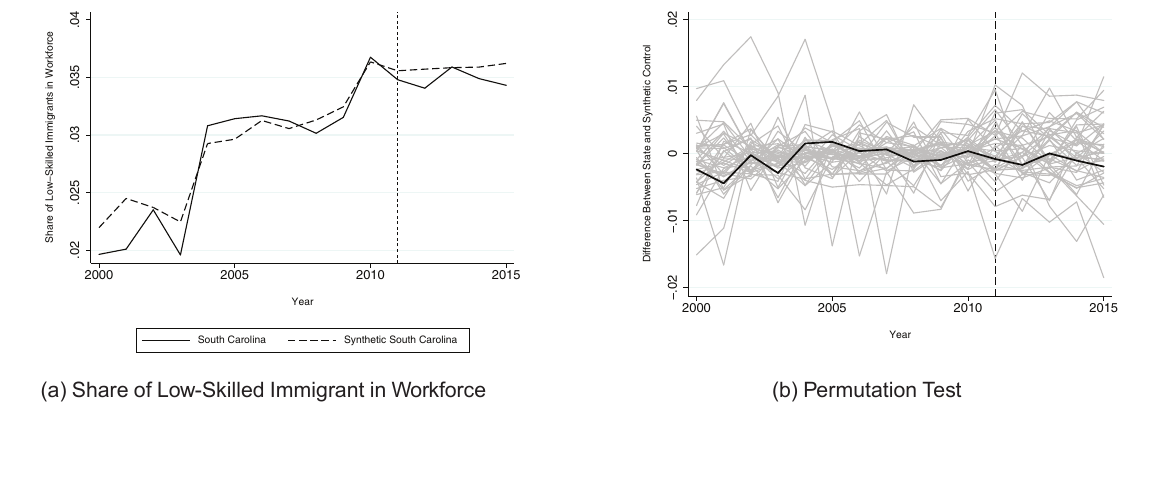
Figure A10 South carolina universal e-verify and share of low-skilled immigrants in workforce